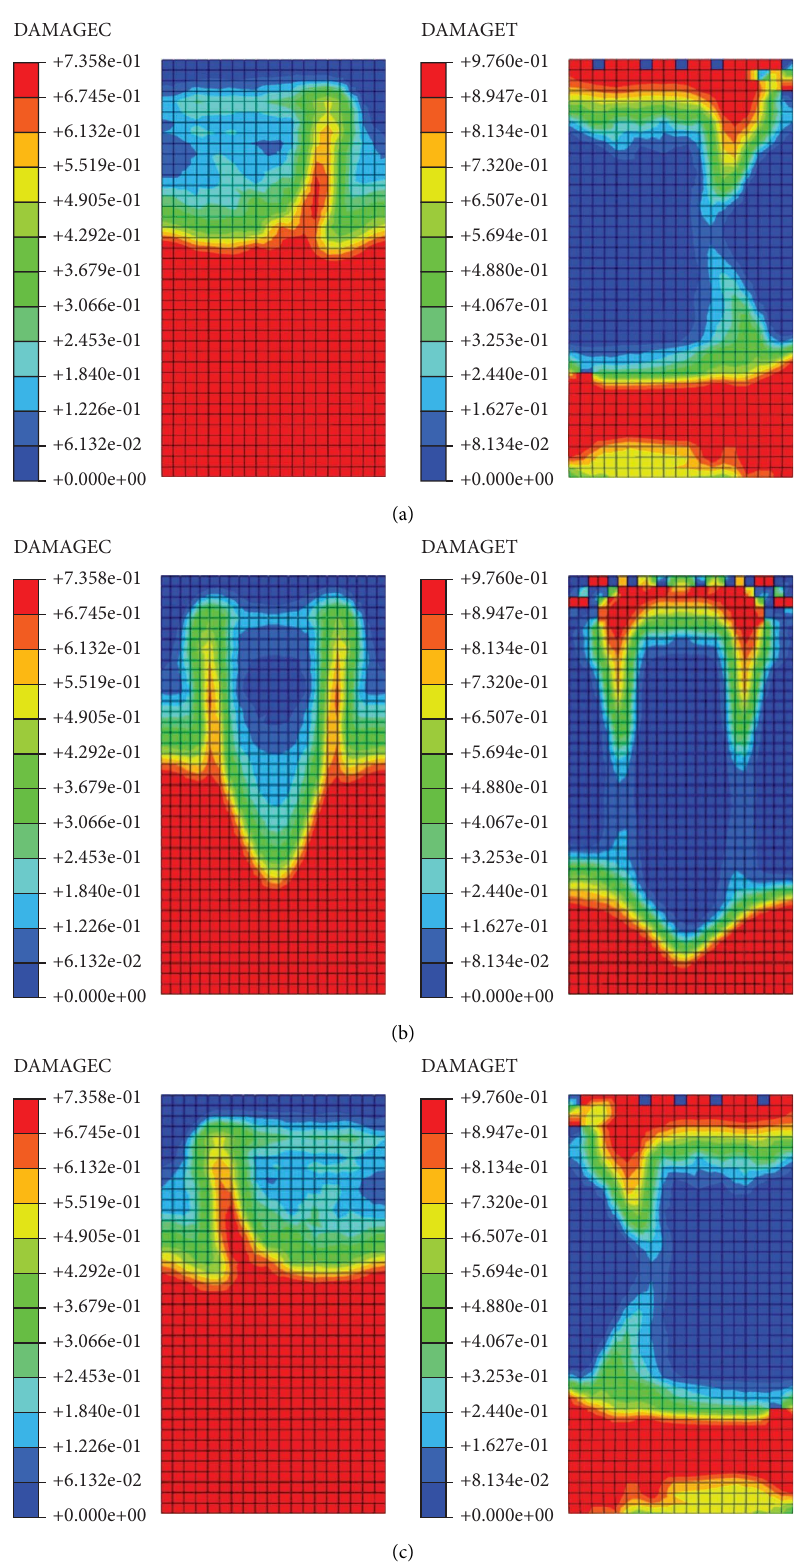
Figure 24: URC-X compression and tensile damage distribution clouds of the member. (a) Wall limb 1 compression and tensile damage distribution clouds. (b) Web compression and tensile damage distribution clouds. (c) Wall limb 2 compression and tensile damage distribution